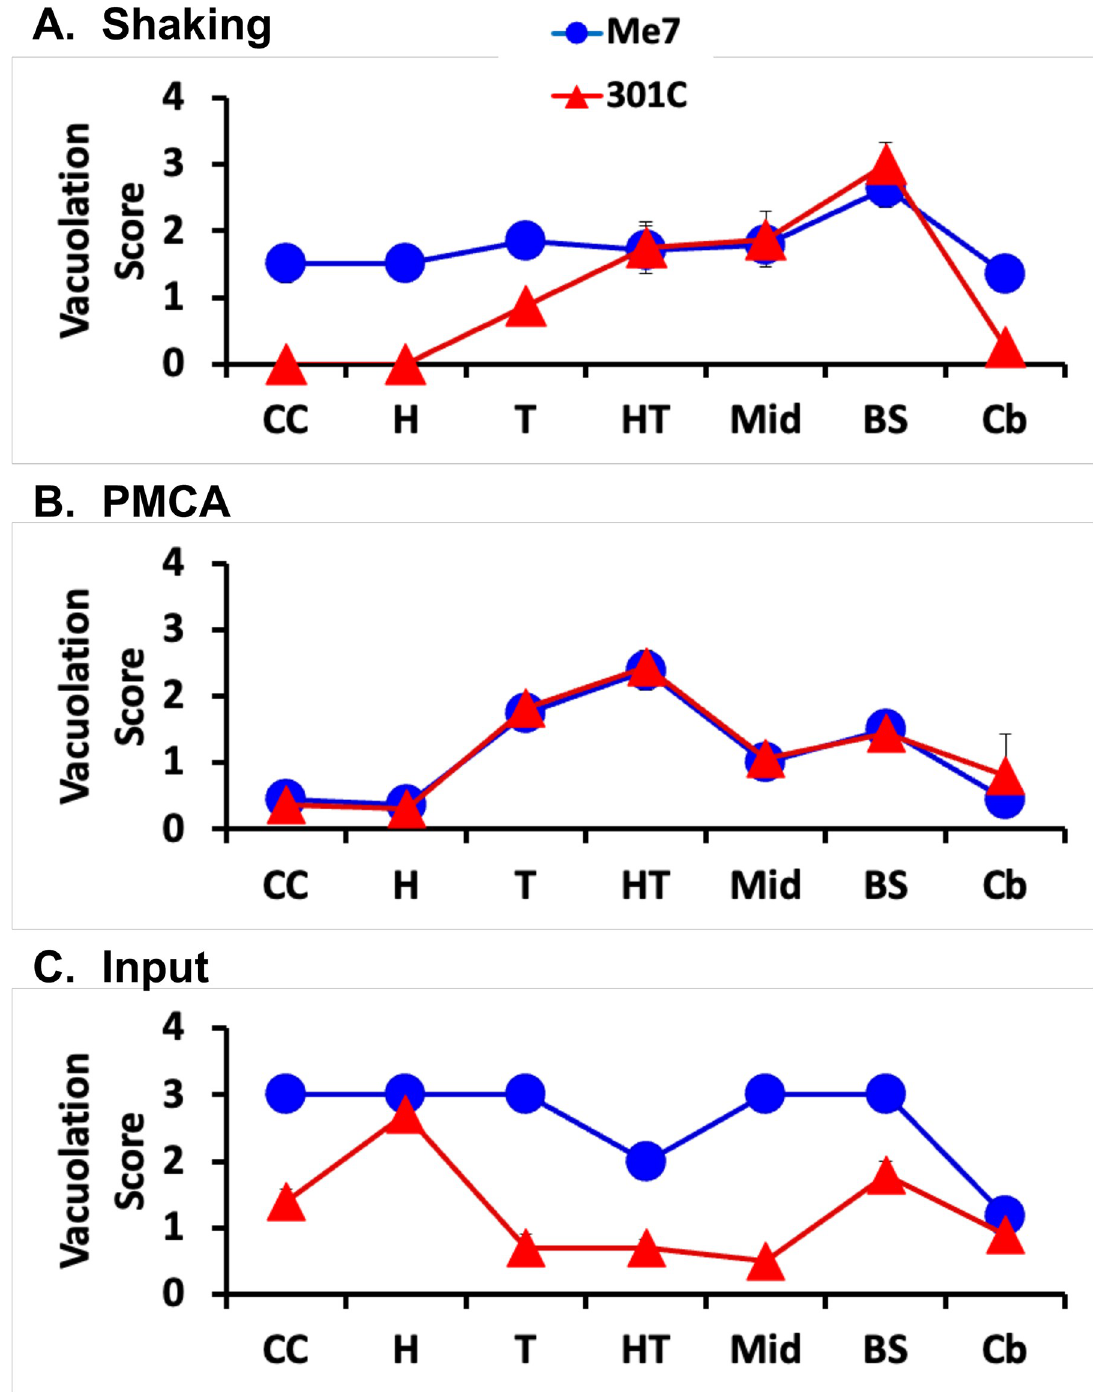
Fig 2. Regional neuropathology of infected mice. Profiles of vacuolation scores of animals inoculated with samples containing A. Shaking-propagated Mo recPrP Sc prions, B. PMCA-propagated Mo recPrP Sc molecules, or C. input prions. Prion strains: Me7 = blue circles, 301C = red triangles. Brain regions: CC = cerebral cortex (all layers), H = hippocampus, T = Thalamus, HT = Hypothalamus, Mid = Midbrain, BS = brain stem, Cb = cerebellum. The mean values (n = 4–8) are shown ± S.E.M.